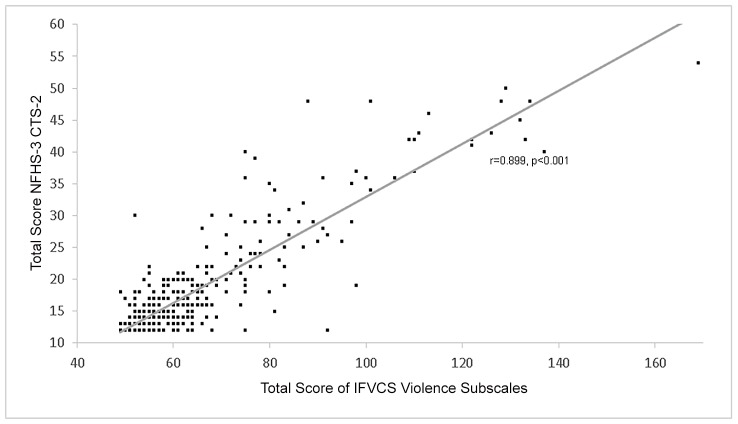
Total Score of the Indian Family Violence and Control Scale Violence Subscales and National Family Health Survey-3 Conflict Tactics Scale-2 Total Score for all participants (n = 630).